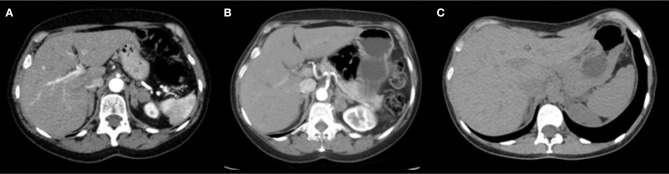
Abdominal CT scan with contrast showing. (A) Index-case: volumetric increase and diffuse nodular thickening of both adrenal glands, stable since 2011. (B) Index-case's sibling: bilateral enlargement of both adrenal glands with multiple hypoattenuating nodules, the largest measuring 2.5 cm (in the medial stem of the left adrenal), all with average attenuation of <10 HU in the non-contrast phase. Such nodules remain stable in relation to the tomographic study from 2015. (C) Index-case's niece: Both adrenal glands with preserved morphology and attenuation without identifiable focal lesions.